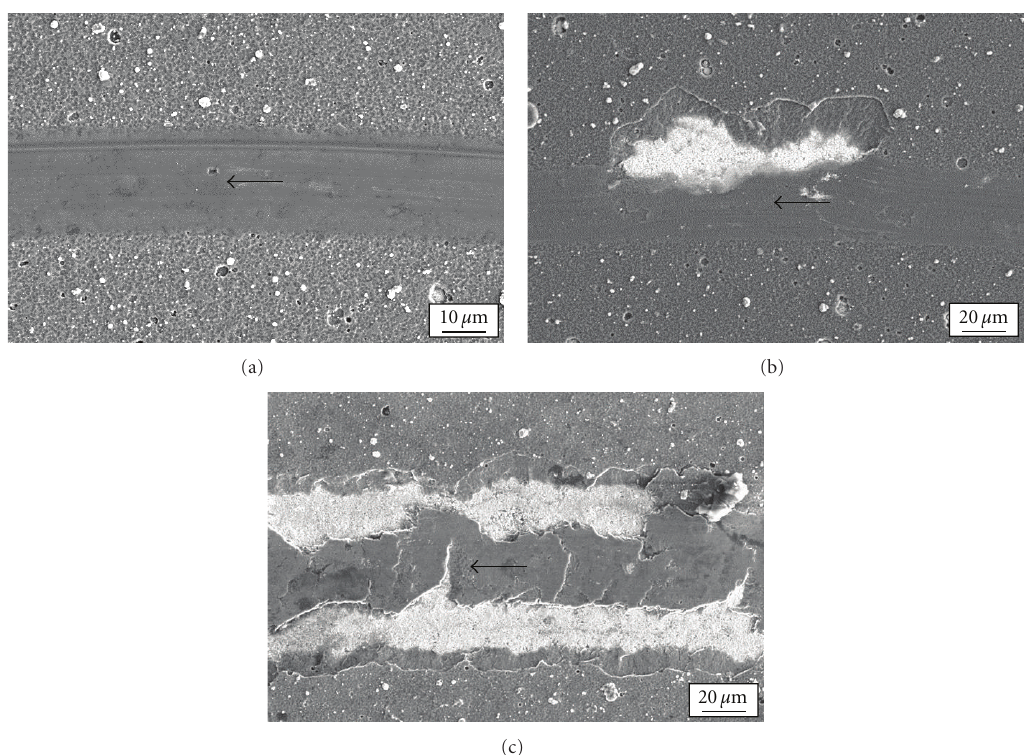
Figure 7: SEM micrographs illustrating the major coating failure mechanisms in the multi-pass scratch test. (a) Plastic deformation and minor cracking (no coating material detached), (b) chipping (cohesive failure) in combination with local interfacial spalling (adhesive failure), and (c) continuous interfacial spalling (adhesive failure) for Ti 0 . 34 Al 0 . 66 N coating. The arrows indicate the scratching direction.